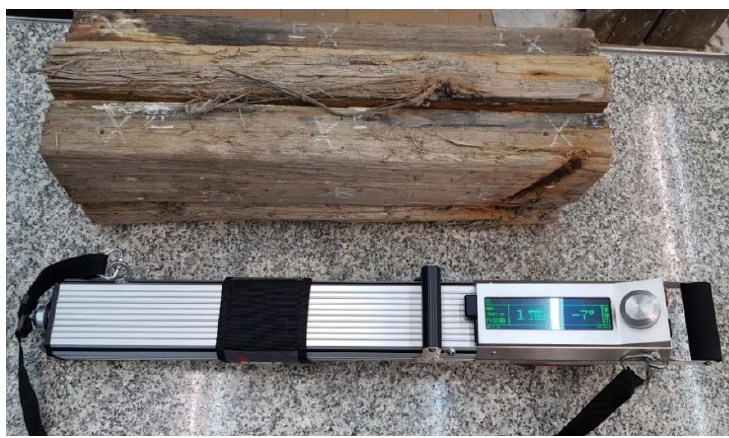
Figure 3. IML RESI PD-400S device used in tests.